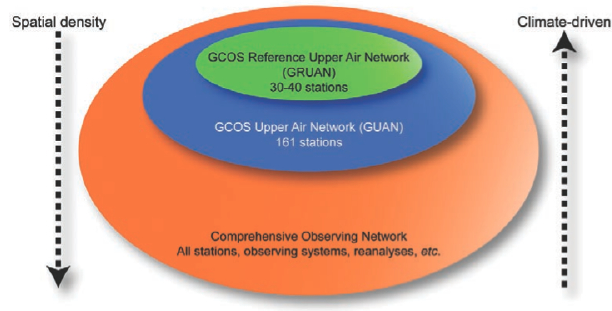
Figure 2. Schematic diagram of the GCOS tiered network concept of upper-air observations for climate. GRUAN offers less spatial density than either GUAN (a subset of the global radiosonde net- work stations that have made commitments of longevity and meta- data collection) or the comprehensive network (which includes all ground-based and satellite upper-air observations and reanalyses) from Seidel et al.